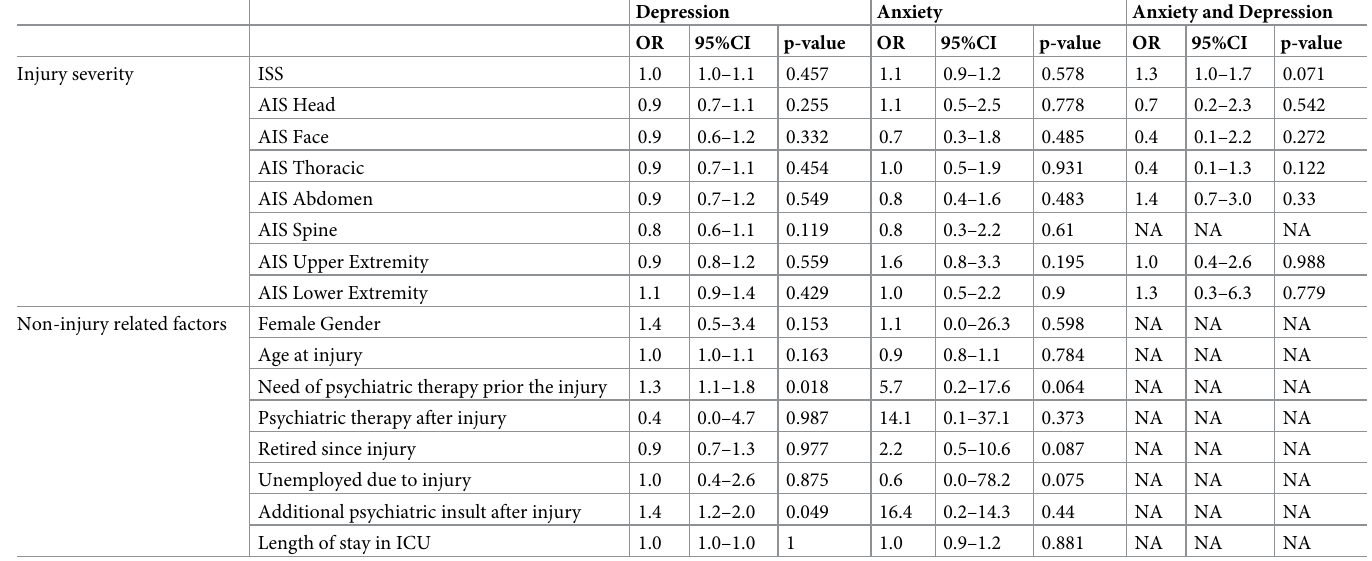
Table 3. Association of injury-related and non-injury-related factors with the development of psychiatric sequelae. The Reference are patients, that did not suffer from symptoms of depression or